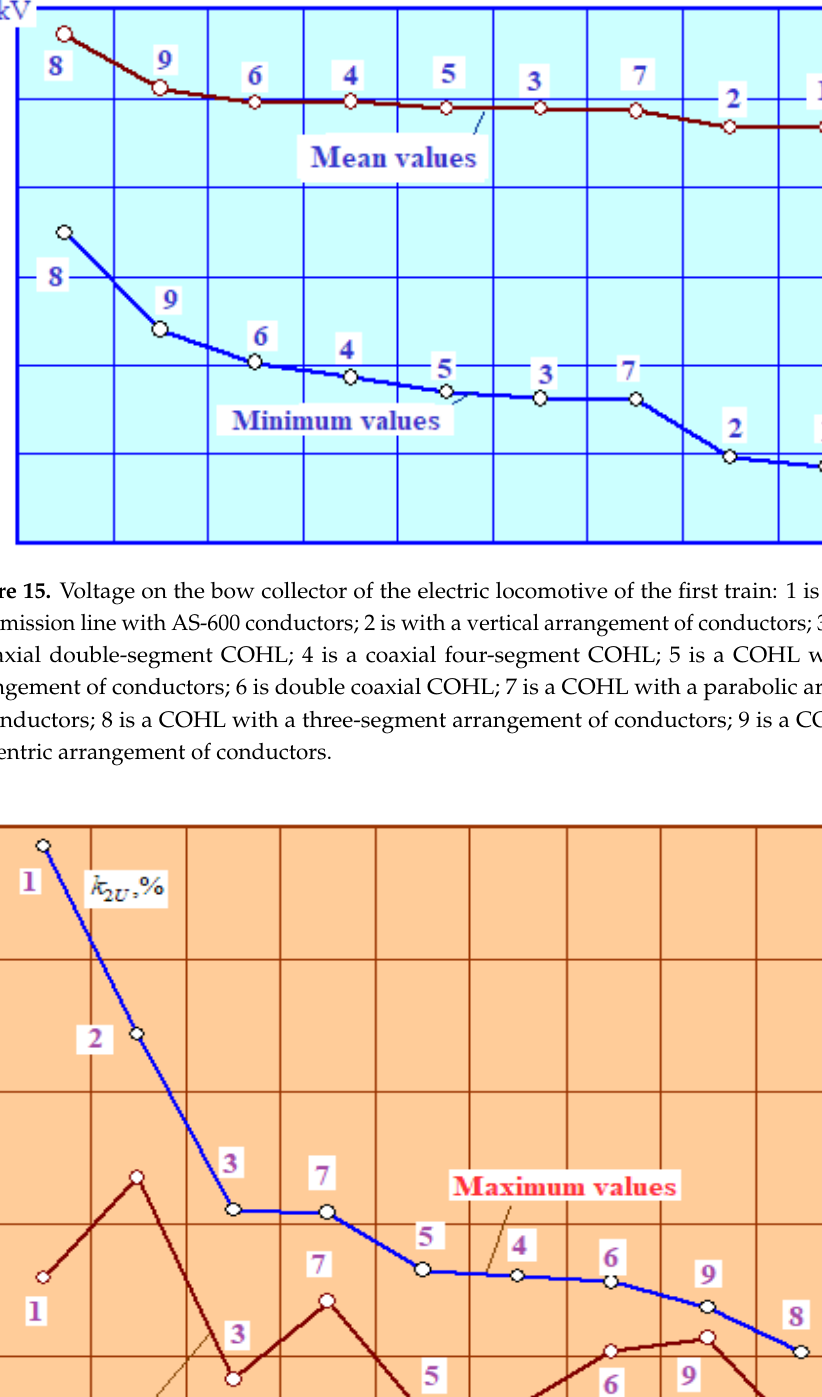
Figure 14. Spatial structure of the EMF strengths of a three - segment compact overhead line.